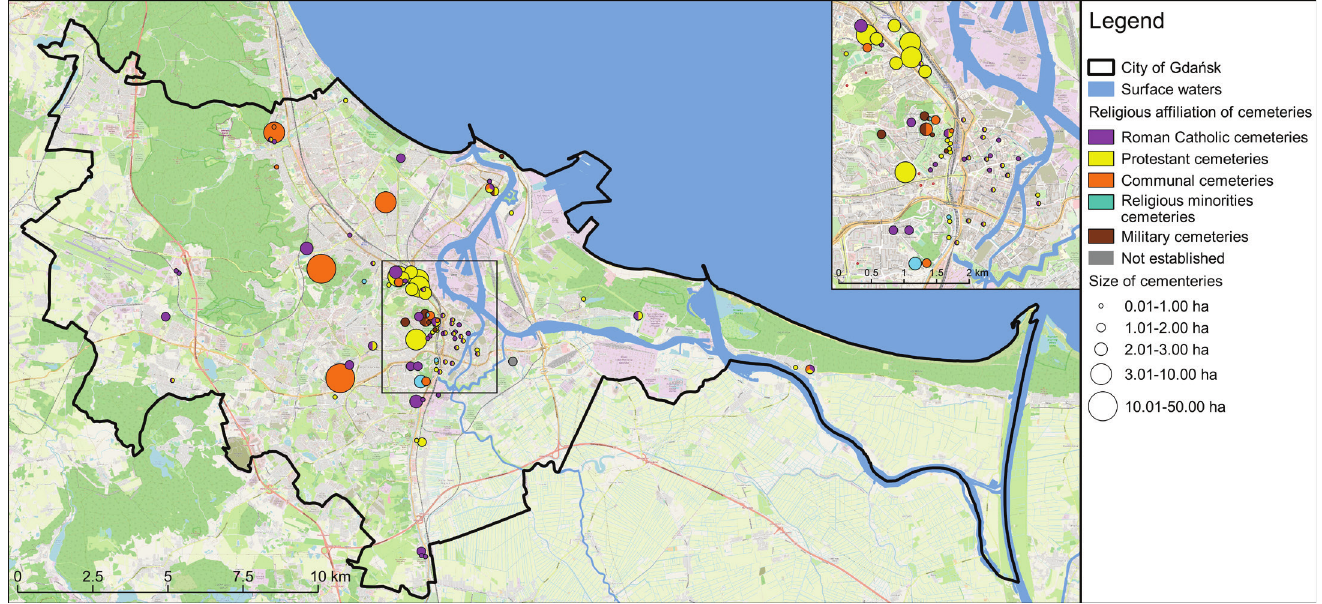
Figure 8. Cemeteries according to their religious affiliation. Source: Own elaboration based on Labenz (1999), changed.